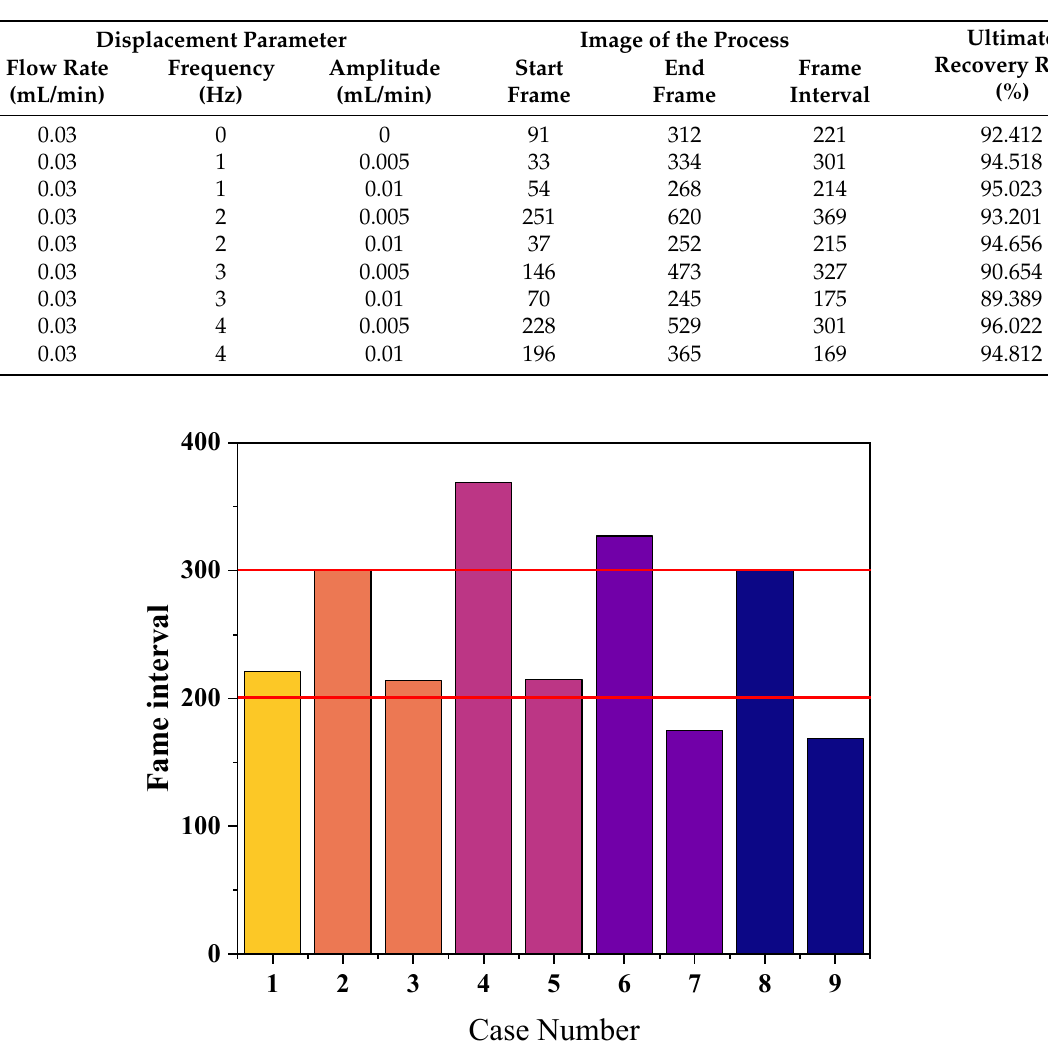
Table 2. The experimental scheme and results.